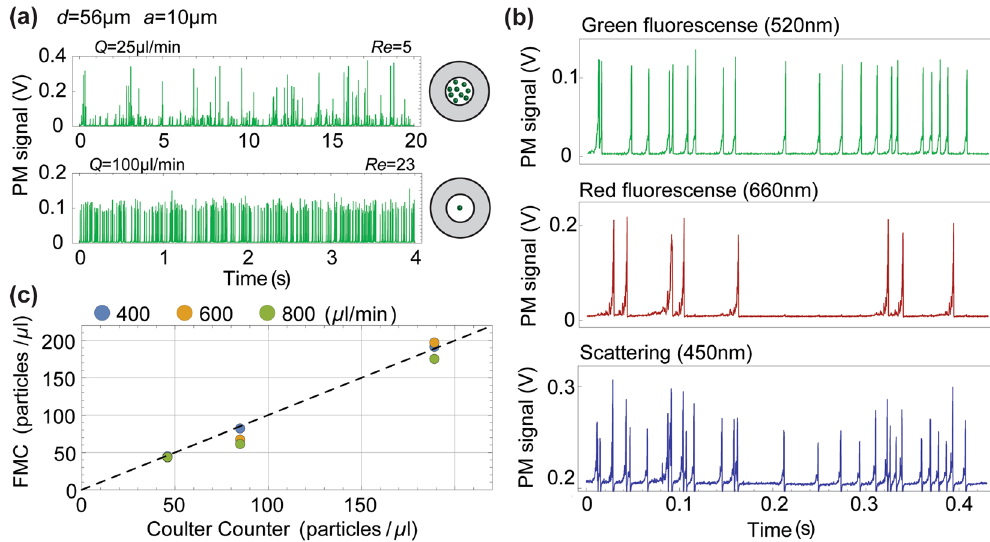
Figure 3. Flow cytometer characterisation. ( a ) Detection of 10- µ m fluorescent particles in a 56- µ m diameter capillary. Photomultiplier (PM) signal for (top) unfocused particles flowing at 25 µ l/min, and (bottom) focused particles flowing at 100 µ l/min; ( b ) Detection of scattering and fluorescence from a mixture of green and red 10- µ m labelled particles. Green, red and blue traces represent green fluorescence centred at 508 nm, red fluorescence centred at 658 nm, and scattering at 450 nm, respectively. A total of 8003 green and 2210 red fluorescence particles are detected in 2 minutes, while the scattering events are 10113; ( c ) Comparison between number of particles measured by the fibre microflow cytometer (FMC) and by Coulter counter for flow rates of 400, 600 and 800 µ l/min and three different concentrations. 15- µ m particles are focused in a 90- µ m capillary.